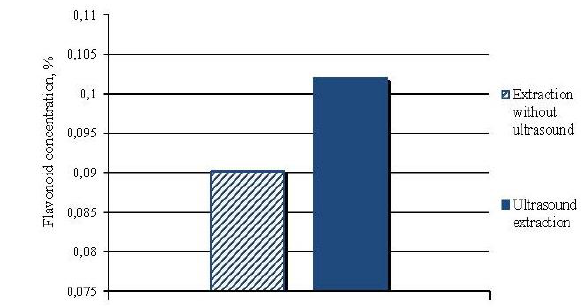
Fig. 6. Ultrasound effect on the amount of flavonoids